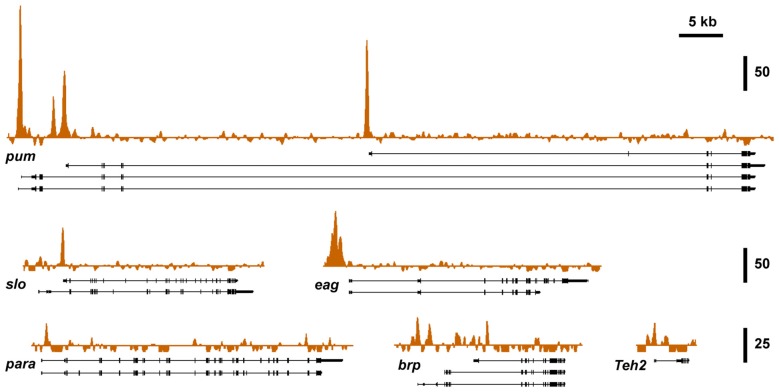
Nejire/CBP binding at different tolerance genes. A survey of basal CBP binding across the six alcohol tolerance genes was acquired from the modENCODE database (Celniker et al., 2009). Peak plots depict ChIP-seq signal obtained from immunoprecipitated chromatin from adult female flies using a CBP antibody superimposed on representative Refseq transcript isoforms for six known tolerance genes. All of these genes have been previously shown to be induced by both benzyl alcohol and ethanol (Ghezzi et al., 2013). Strong Nejire/CBP binding is localized near the transcription start sites or within the first exon of these genes. Vertical scale bars denote fold enrichment over input.